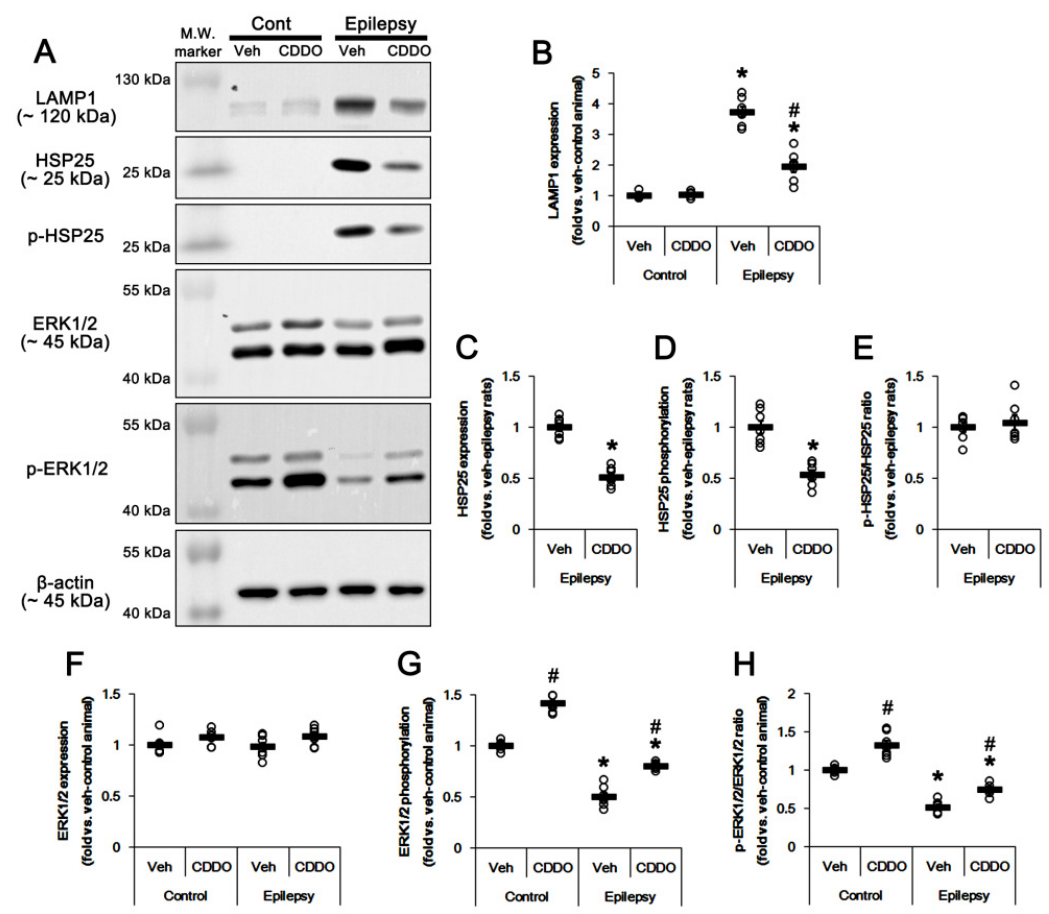
Figure 3. Effects of CDDO-Me on LAMP1, HSP25, p-HSP25, ERK1/2 and p-ERK1/2 levels in the CA1 region of control and epileptic rats. As compared to control animals (Cont), LAMP1, HSP25 and p-HSP25 levels were enhanced in the CA1 region of epileptic rats. However, extracellular signal-related kinases 1/2 (ERK1/2) phosphorylation (p-ERK1/2) level was diminished in epileptic rats without altering its protein level. CDDO-Me treatment decreased protein expression and phosphorylation of LAMP1 and HSP25, but increased ERK1/2 phosphorylation. ( A ) Representative Western blot for LAMP1, HSP25, p-HSP25, ERK1/2 and p-ERK1/2 in the CA1 regions. ( B–H ) Quantitative values (mean ± SEM) of protein, phosphorylation and phosphorylation ratio concerning LAMP1 ( B ), HSP25 ( C–E ) and ERK1/2 ( F–H ) ( n = 7). Open circles indicate each value. Horizontal bars indicate the mean value. Significant differences are * ,# p < 0.05 vs. control animals and vehicle-treated animals.